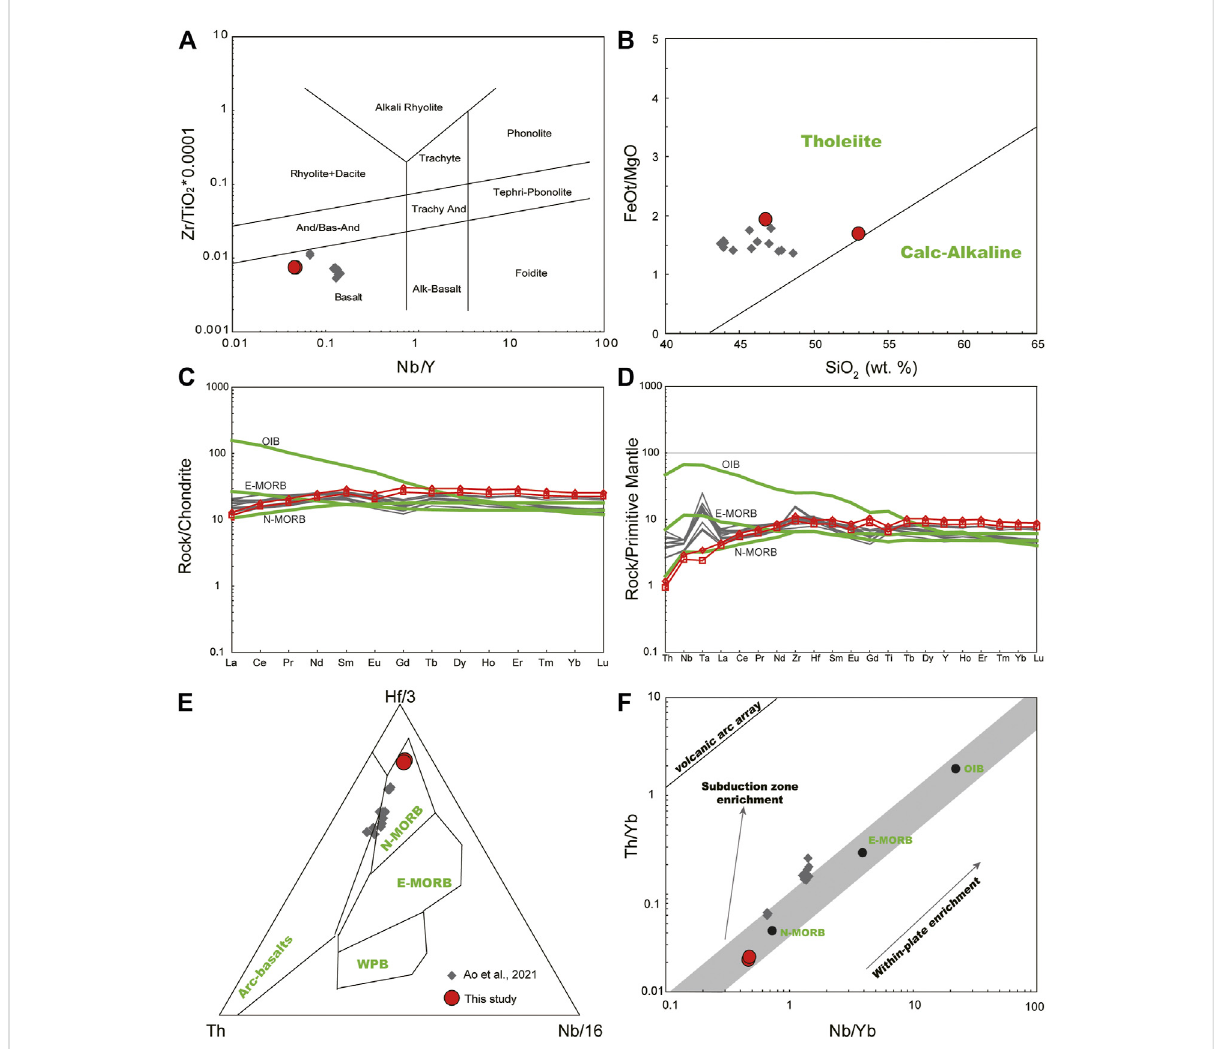
FIGURE 8 Geochemical diagrams of the basalt in the northern HL area of the KGSC. (A) Zr/Ti vs. Nb/Y diagram (Winchester & Floyd, 1977) and (B) FeO t / MgOvs.SiO 2 diagram(Myashiro,1974), (C) Chondrite-normalizedREEand (D) primitivemantlenormalizedmultielementdiagrams.Chondritevalues are from a previous study (Boynton, 1984). The PM values are from a previous study (Sun and McDonough, 1989). (E) Hf-Th-Ta diagram (Hawkins, 2003;Wood,1980)and (F) Nb/Ybvs.Th/Ybdiagram(Pearce,2008).The fi eldsoftheTofuaArc,LauBasinandMarianaTrougharefromHawkins (2003). The basaltic fragments in the northern HL area are similar to those of N-MORBs. The dark diamonds and lines are after Ao et al.